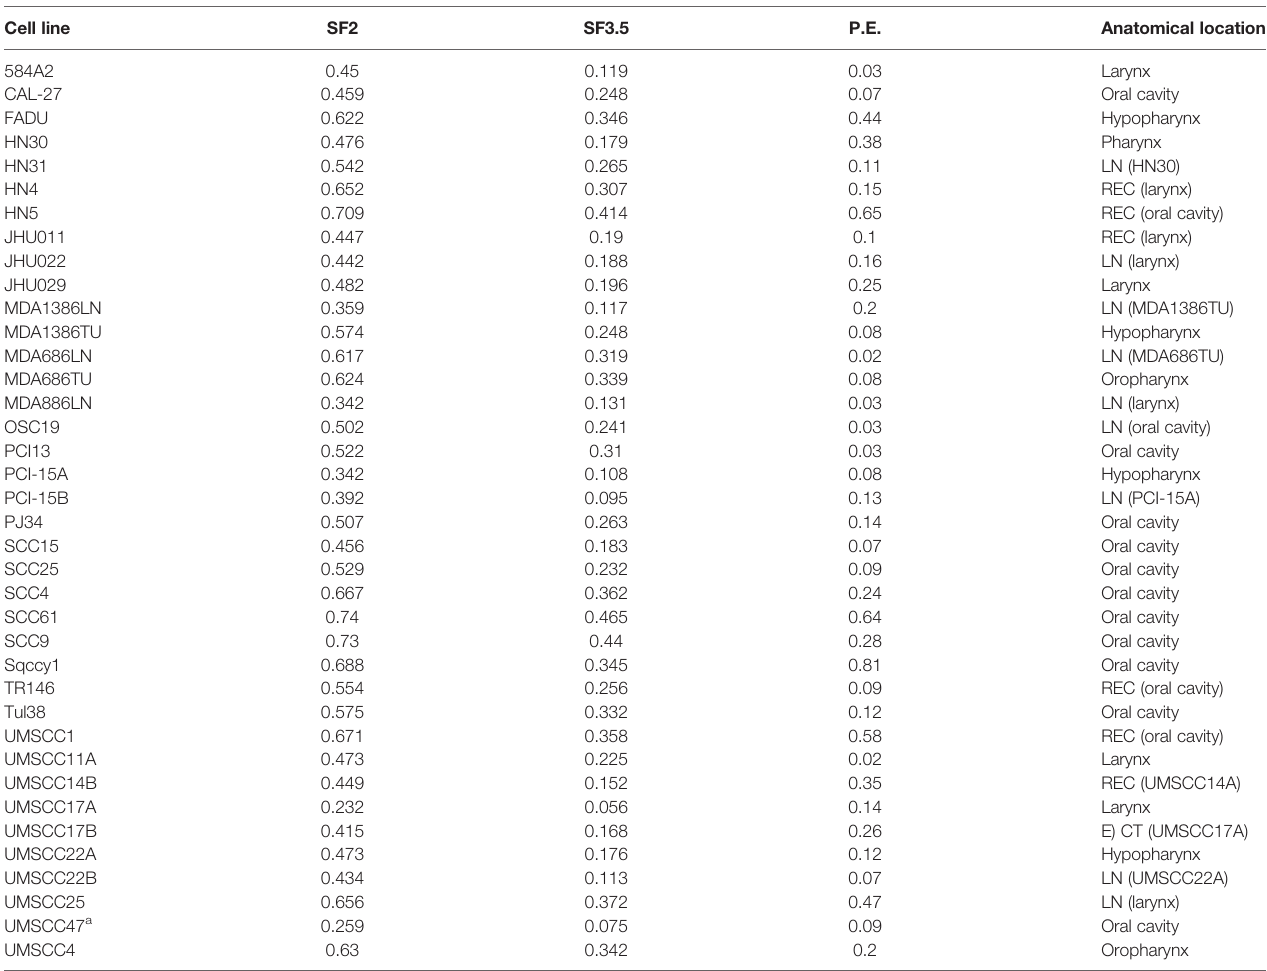
TABLE 1 | Characteristics of HNSCC cell